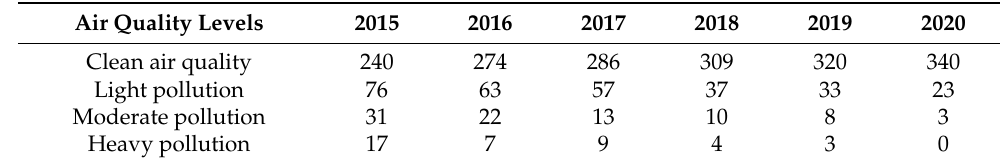
Table 2. Interannual variations in frequency (days) of different air quality levels with daily PM 2.5 concentrations observed in Wuhan from 2015 to 2020.